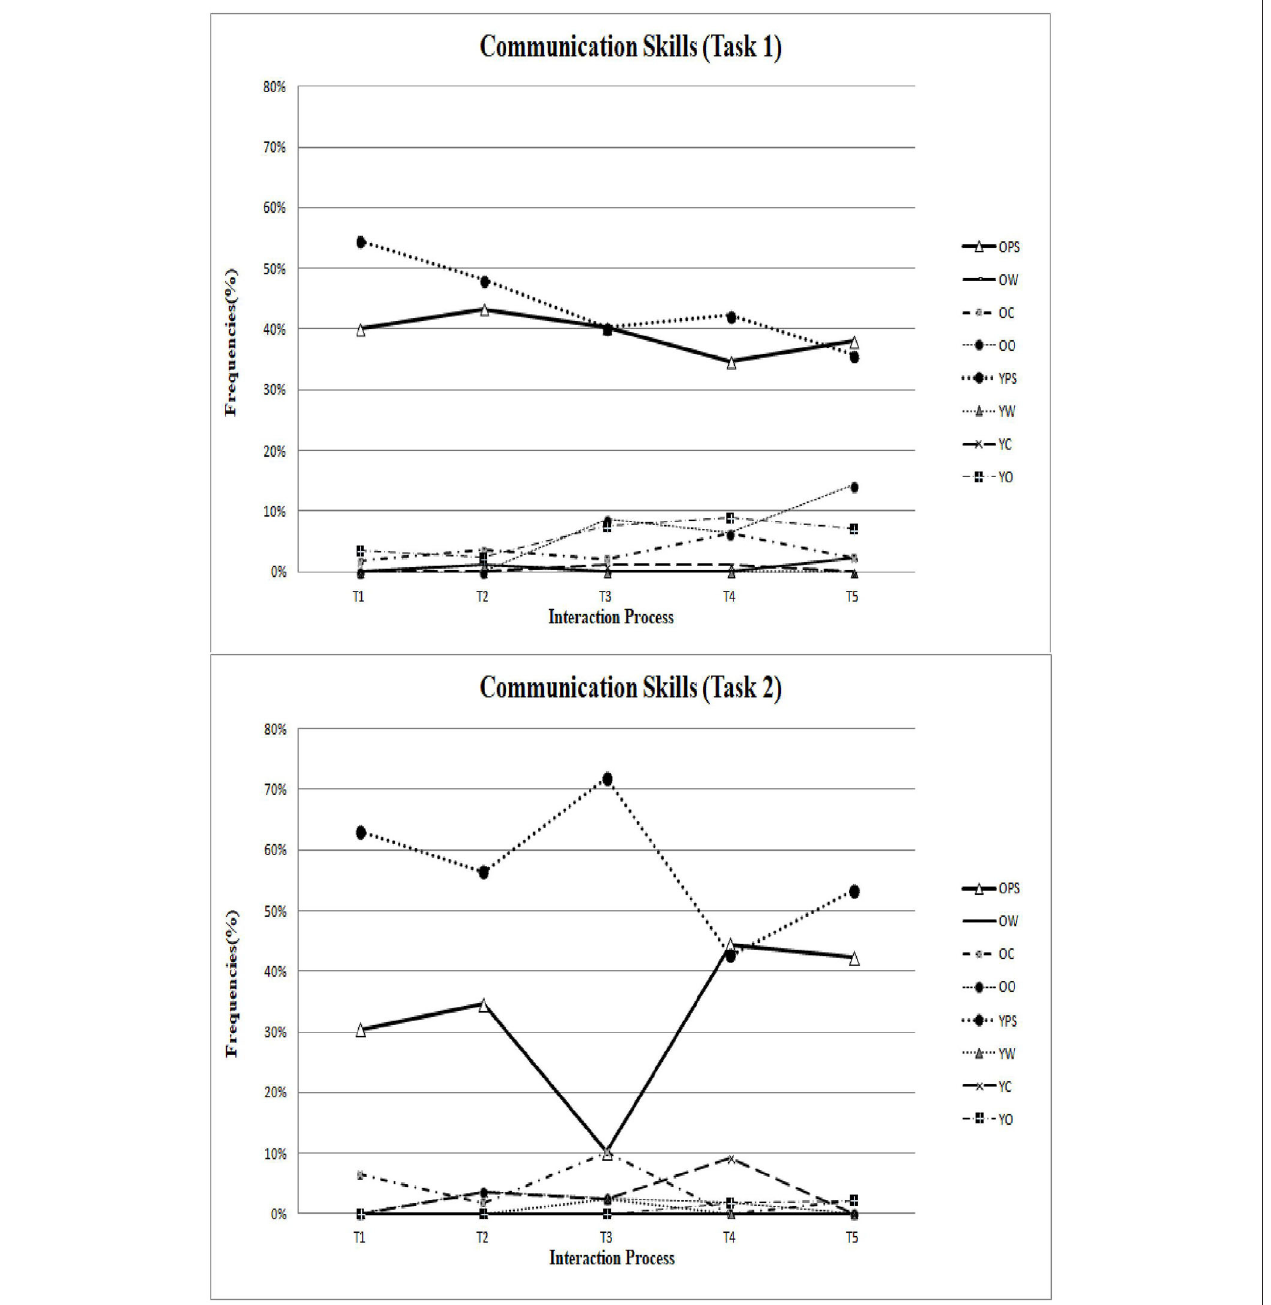
FIGURE 2 | The patterns of communications skills in Task 1 and Task